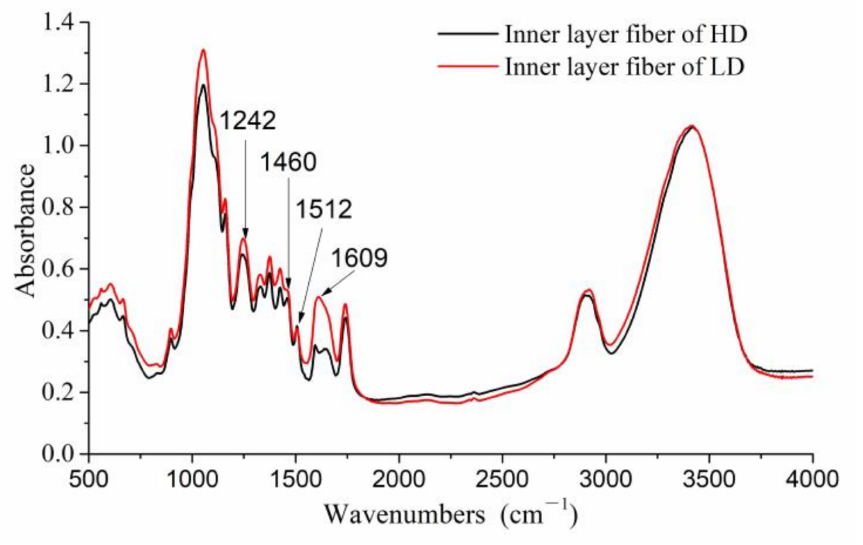
Figure 4. Fourier transform infrared (FTIR) spectra of high/low-density LS